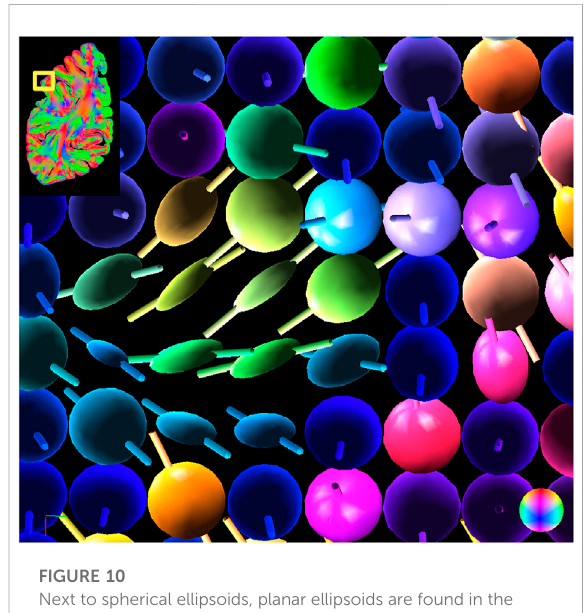
FIGURE 10 Next to spherical ellipsoids, planar ellipsoids are found in the cortex, indicating high con fi dence in one angle and low con fi denceintheother.Inadditiontotheellipsoids,themostlikely fi ber orientations are visualized as small sticks to underline the fl at